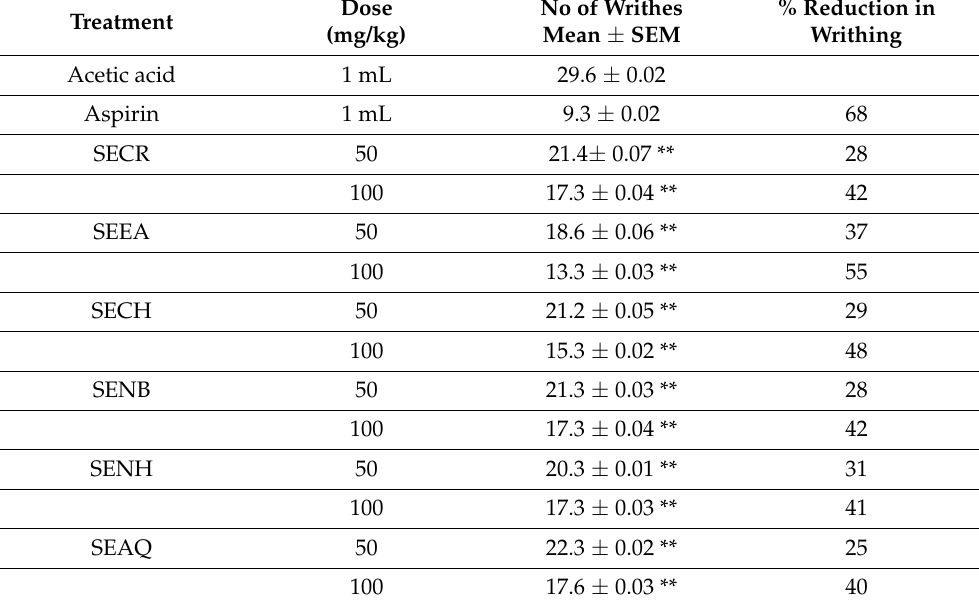
Table 5. Analgesic activities of S. edelbergii